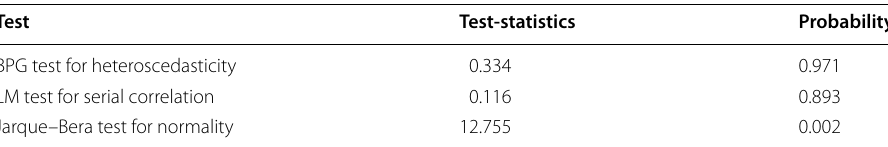
Fig. 6 NARDL dynamic multiplier graph for ID (Source: authors’ illustration from UNDP, WDI, and ETH Zurich KOF